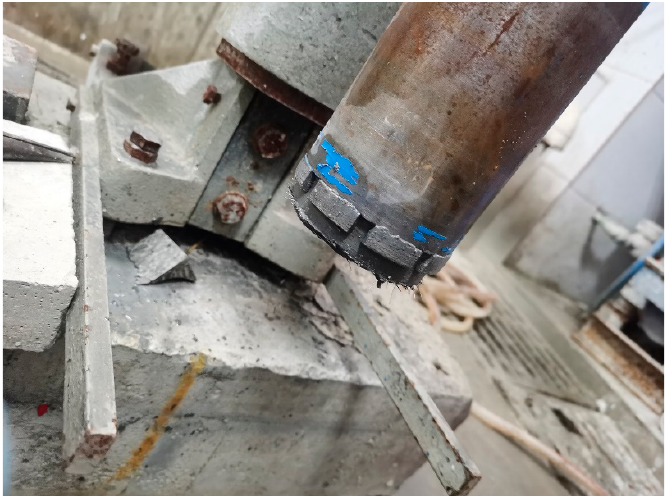
Figure 1. UHPC cylindrical specimen for dynamic test.